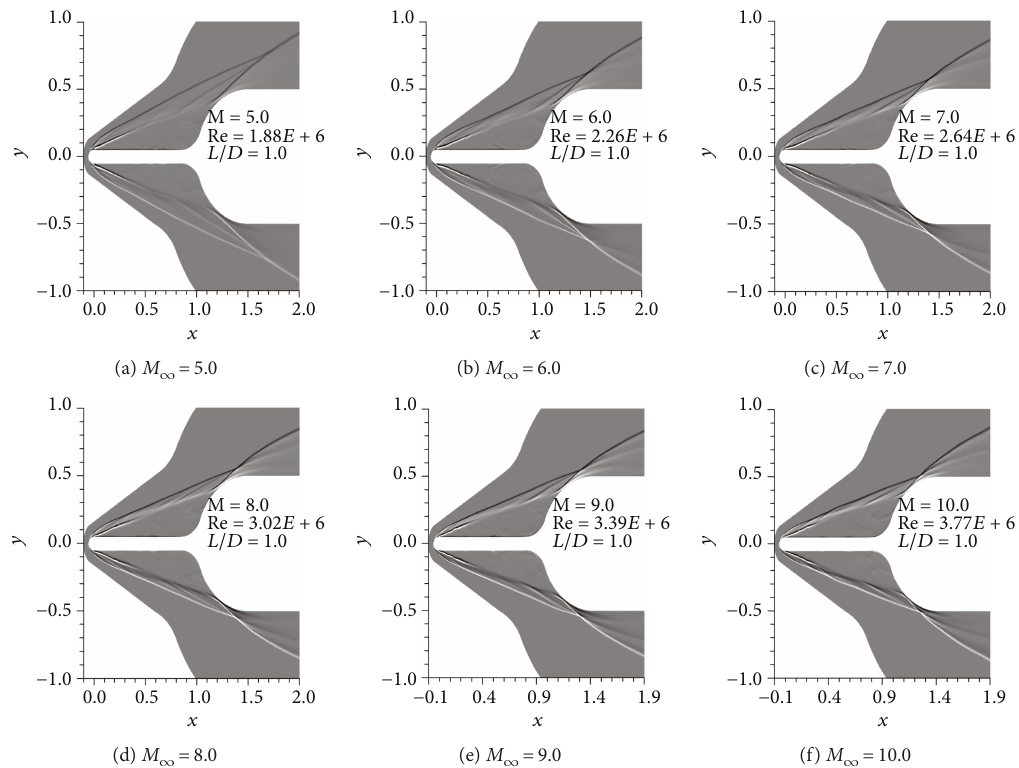
Figure 14: Flow fi eld density gradient in y direction of spiked blunt bodies with the sideward sonic jet. Spike length L/D =